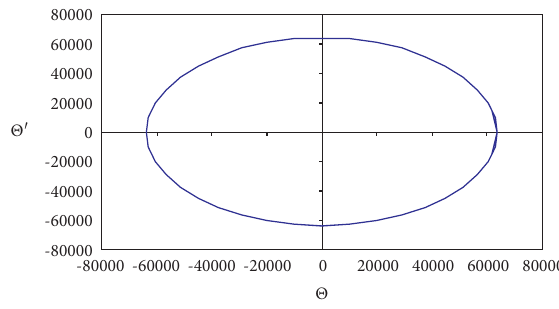
Figure 30: The stability phrase Θ ′ and Θ for case (iii) in Section 4.2.